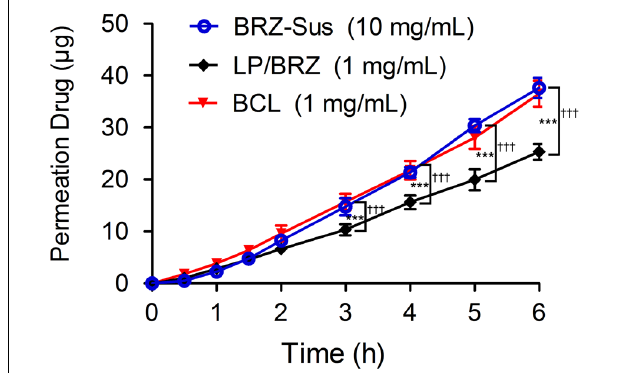
FIGURE 6 | In vitro transcorneal permeation profiles of BRZ-Sus, LP/BRZ, and BCL versus time. Data are expressed as mean ± SD ( n = 3)